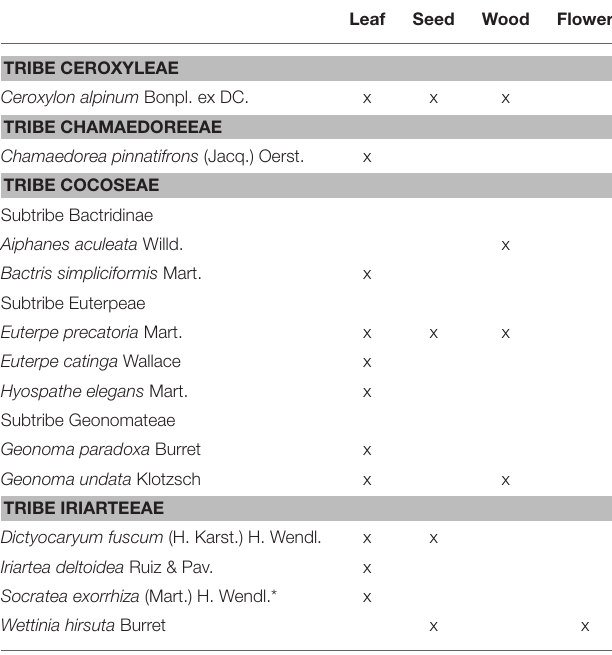
TABLE 1 | Herbarium material sampled from palm species occurring on the eastern Andean flank between 1,000 and 3,000m above sea level (masl). Leaf Seed Wood Flower TRIBE CEROXYLEAE